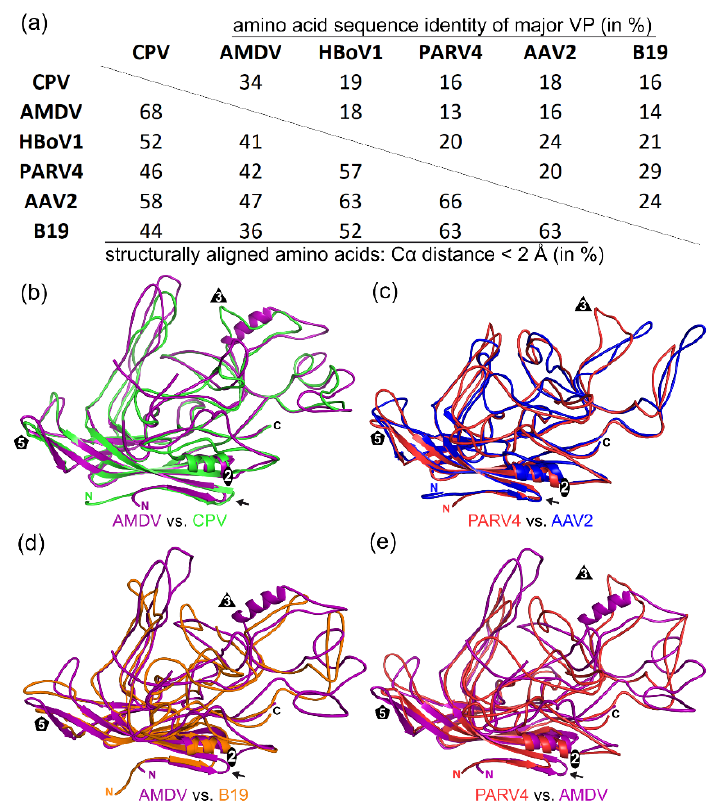
Figure 5. Sequence and structural comparison. ( a ) Amino acid sequence identity comparison of the major VPs (top right) between CPV, AMDV, HBoV1, PARV4, AAV2, and B19 (in %). Structural similarity (bottom left) was defined as the percentage of aligned C α atoms of the amino acid chain within 2 Å distance when the capsid structures were superposed. ( b ) Superposition of AMDV (purple) and CPV (green). The N- and C-termini and the approximate icosahedral two-, three-, and five-fold axes are indicated. ( c ) Superposition of PARV4 (red) and AAV2 (blue). ( d ) Superposition of AMDV (purple) and B19 (orange). ( e ) Superposition of PARV4 (red) and AMDV (purple). Arrows indicate the position of the AB loop.